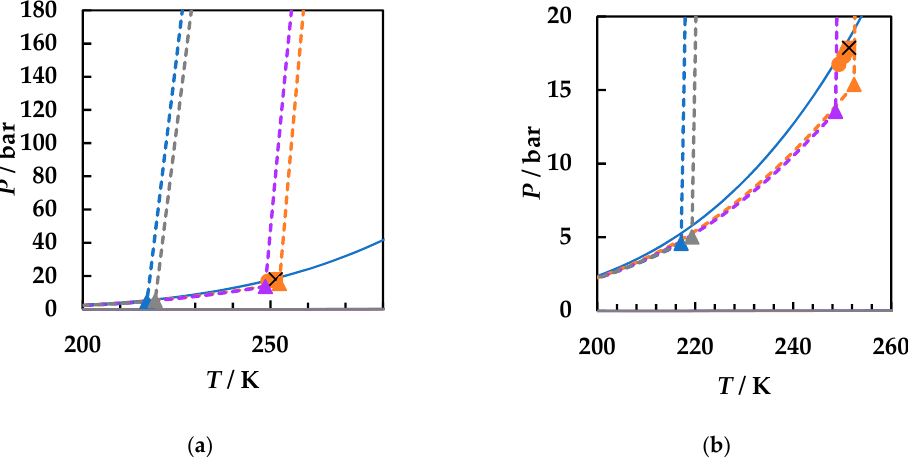
Figure 2. P – T fluid phase diagrams for carbon dioxide (1) + ethyl acetate (2), + 1,2-dimethoxyethane (2), + 2-butanol (2), and + 1,4-dioxane (2) binary systems calculated with PR EoS. ( a ) Detail of the predicted liquid–liquid critical lines, upper critical endpoints, and three-phase equilibrium lines. ( b ) Enlargement of the three-phase region. PR EoS predictions: dashed lines and triangles. Experimental data: cross (UCEP), circles, and square [45]. CO 2 + ethyl acetate ( blue ); CO 2 + 1,2-dimethoxyethane ( gray ); CO 2 + 2-butanol ( orange ); CO 2 + 1,4-dioxane ( purple ).